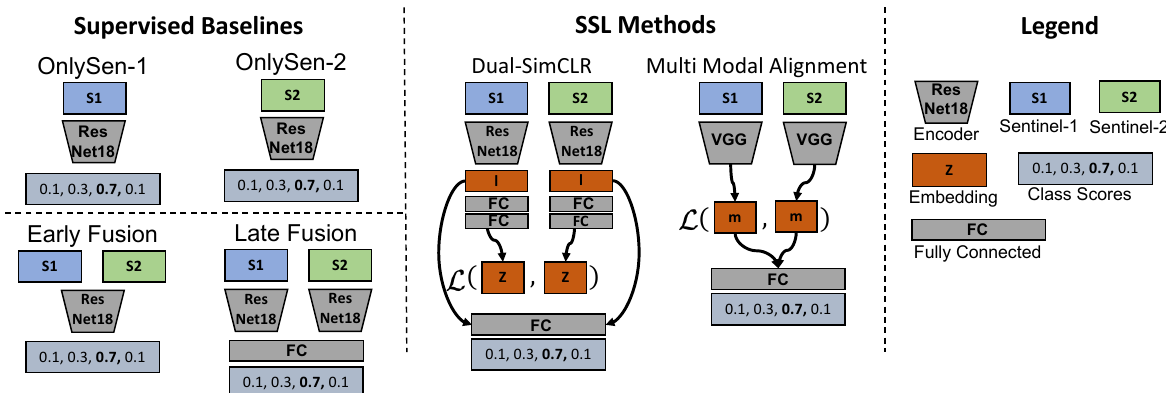
Figure 3. Overview of the model architectures for supervised (left) and self-supervised (middle) land-cover classification approaches including fully-connected classification